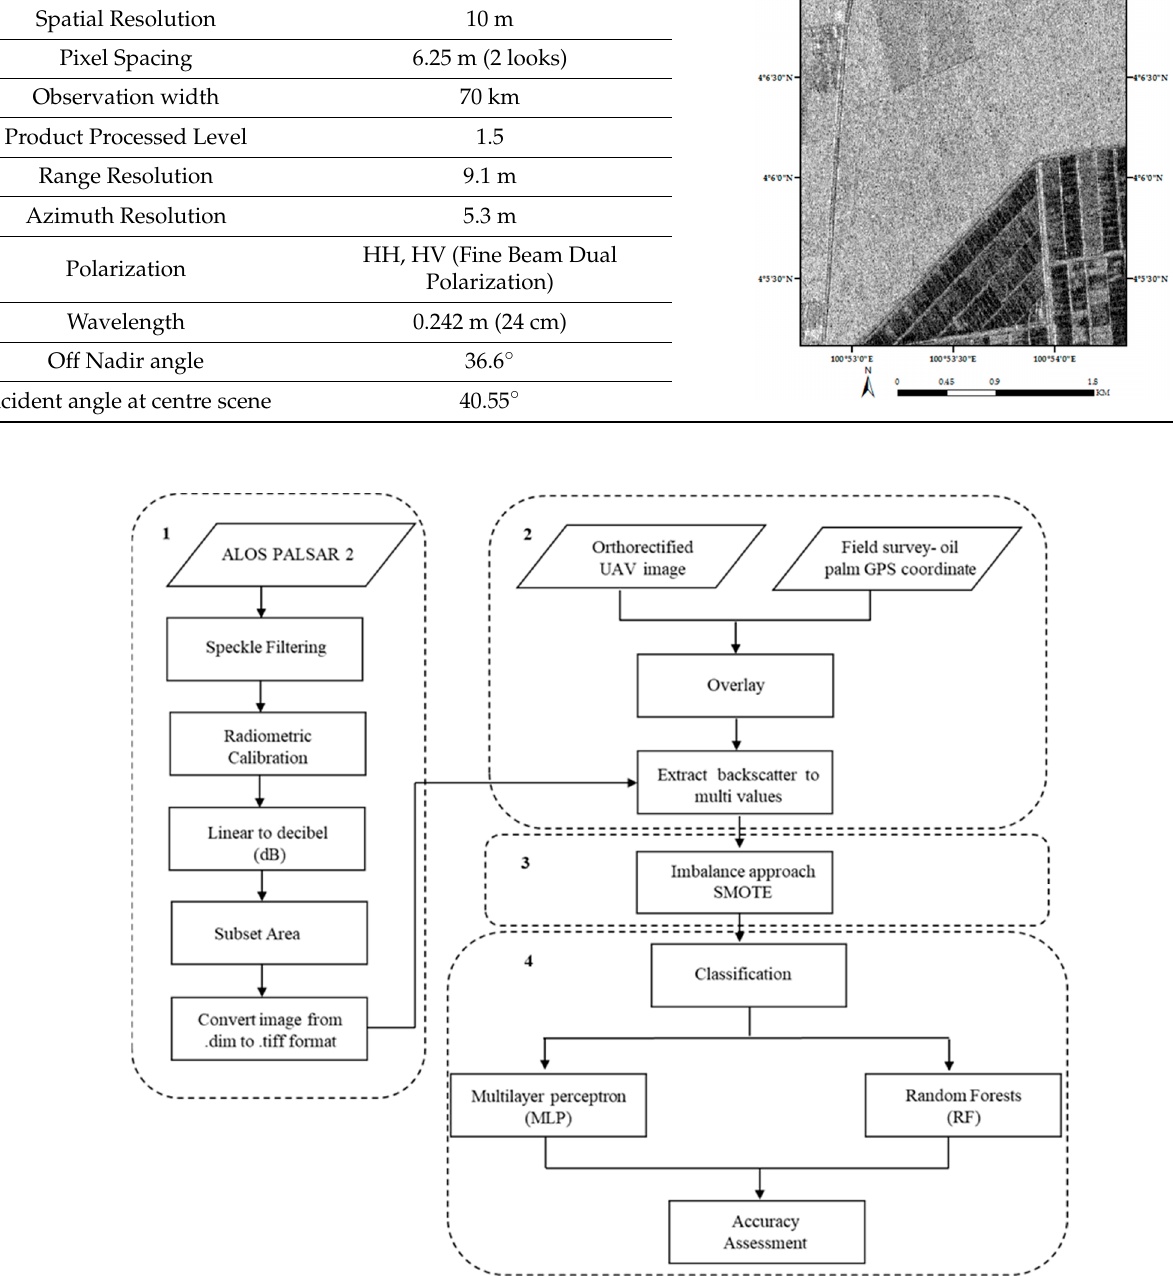
Figure 3. Research workflow—( 1 ) SAR image pre-processing; ( 2 ) extraction of all pixel values for oil palm trees based on census data; ( 3 ) imbalanced data approach; and ( 4 ) classification of trees that were non-infected and infected by G.boninense in the study area.